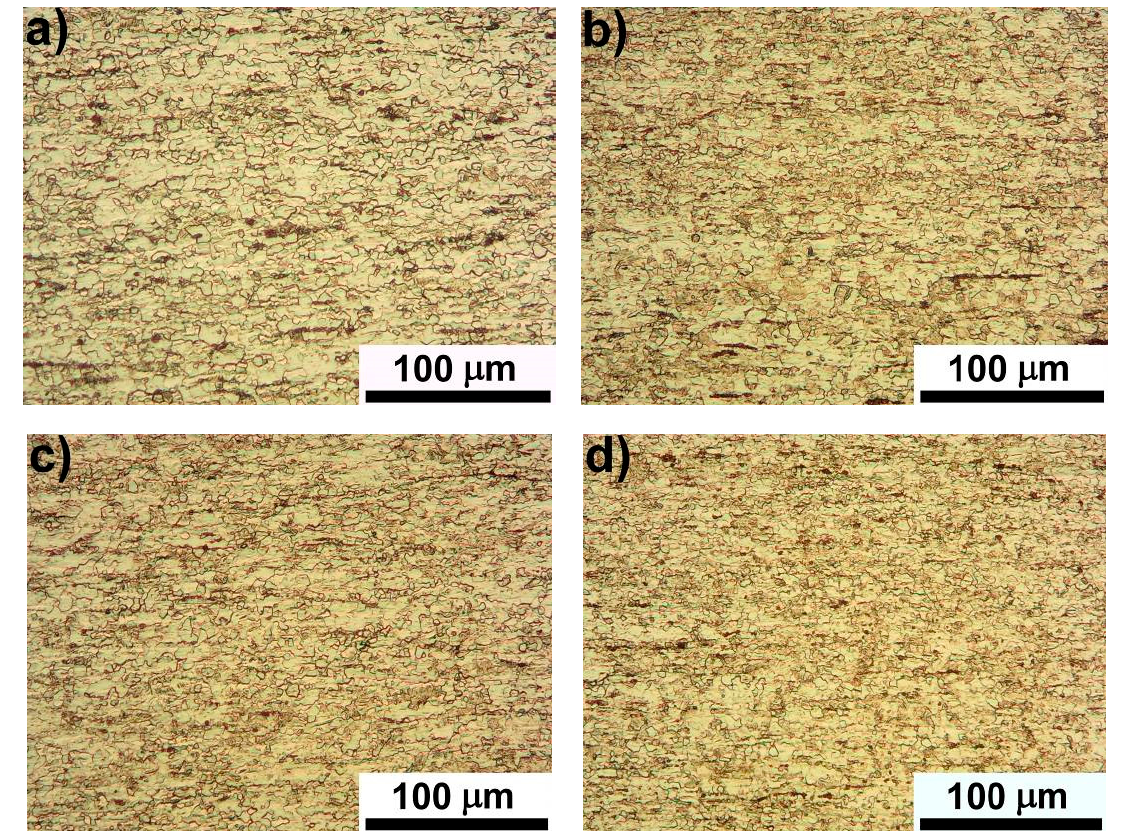
Figure 8. Microstructures of manufactured Ti Gr4 rods revealed by etching, longitudinal section, light microscopy: ( a ) variant V1, ( b ) variant V2, ( c ) variant V3, ( d ) variant V4. Table 8. Results of the stereological analysis of the microstructure of Ti Gr4, where: E(d 2 )—aver- age grain size, SD—standard deviation, CV—coefficient of variation, α and β —shape factors (a description of the stereological parameters is included in chapter “Investigation methods”).